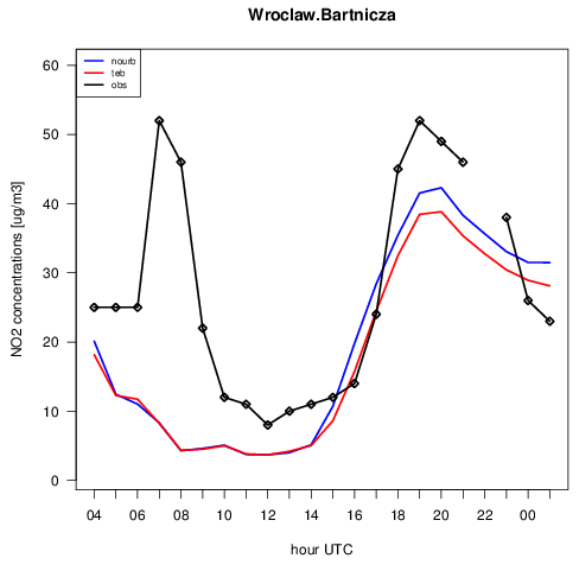
Fig. 15. Comparison of modelled NO 2 concentrations with observa- Figure 15 Comparison of modelled NO tions from station Wroclaw-Bartnicza for 29 March 2011 (red line - urban scenario, blue line - non-urban scenario, black line - obser- Wroclaw-Bartnicza for 29th of March 2011 (red line – urban scenario, blue line = non- vations).